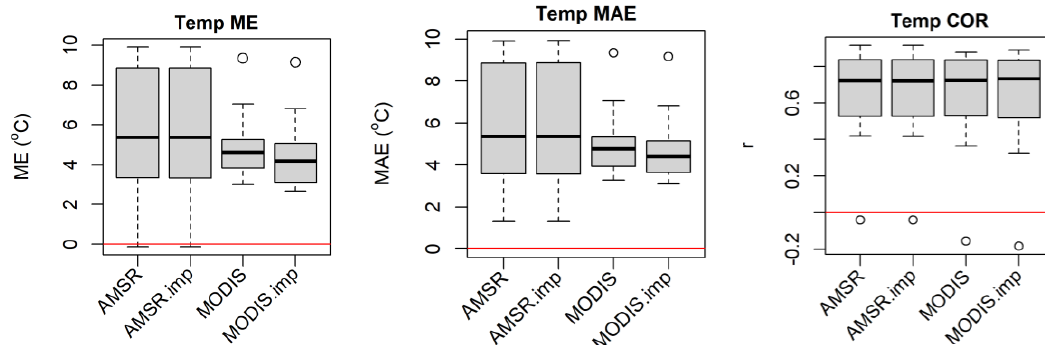
Figure 3. Comparative accuracy statistics box plot of non-imputed and imputed daily AMSR air temperature and MODIS LST for 22 meteorological stations distributed in the Amhara Region, Ethiopia for 2003–2016. Note the distinct differences of comparative box plots for the MODIS data mean error (ME) and mean absolute error (MAE).